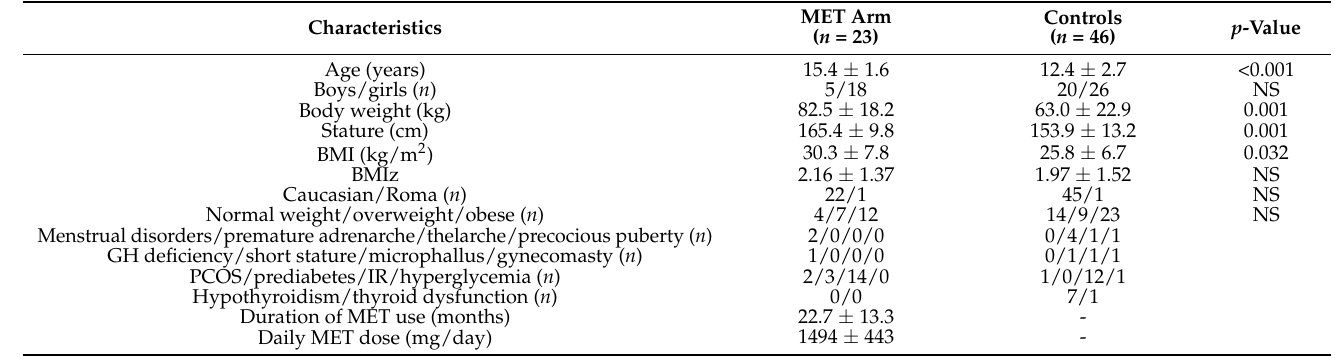
Table 4. Characteristics of the participating children and adolescents in each study group *.